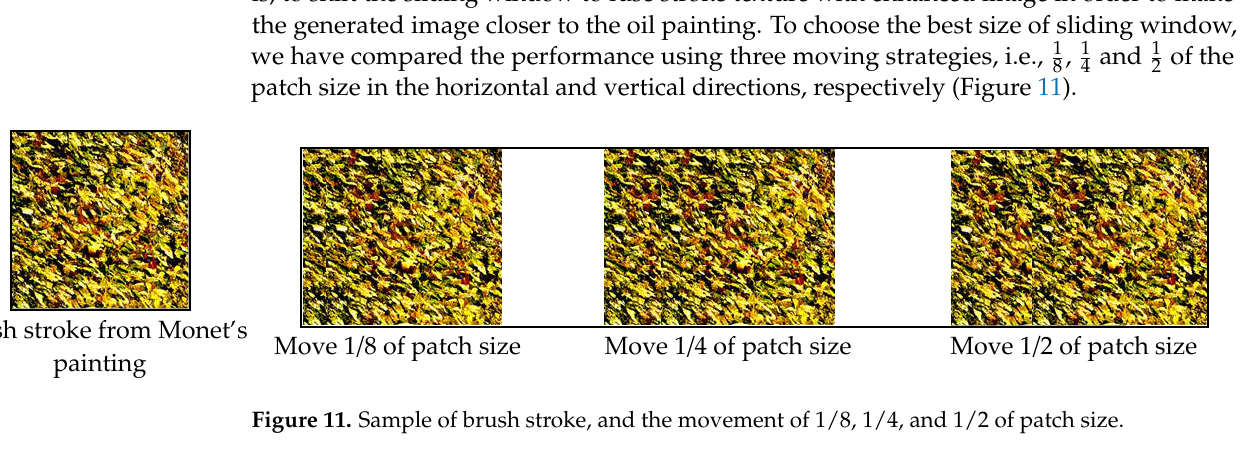
portrait 1, the selection of 1/4 and 1/2 for the patch size gives the same score. On the other hand, for landscape 2 and portrait 2, the selection of 1/8 for the patch size is not ideal. In this way, if the number of overlapping becomes less, the number of mixing colors becomes less.